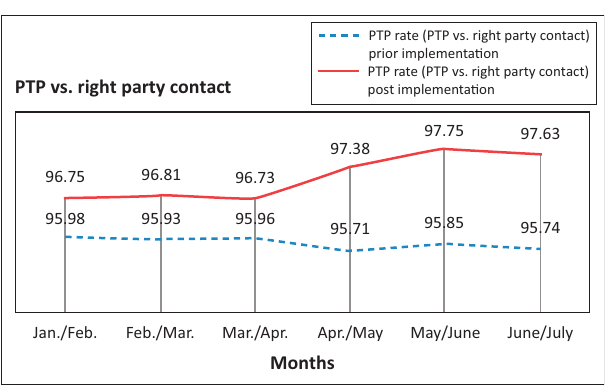
FIGURE 2: Average dropped call rate.